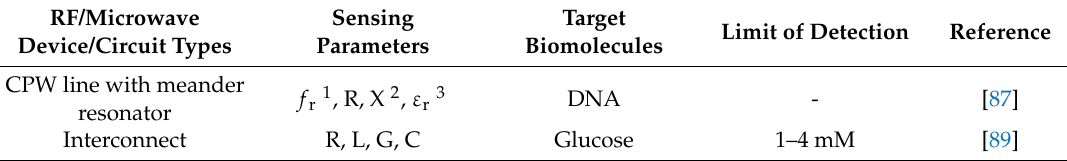
Table 3. Types of rGO or GO-based RF/microwave biosensors.